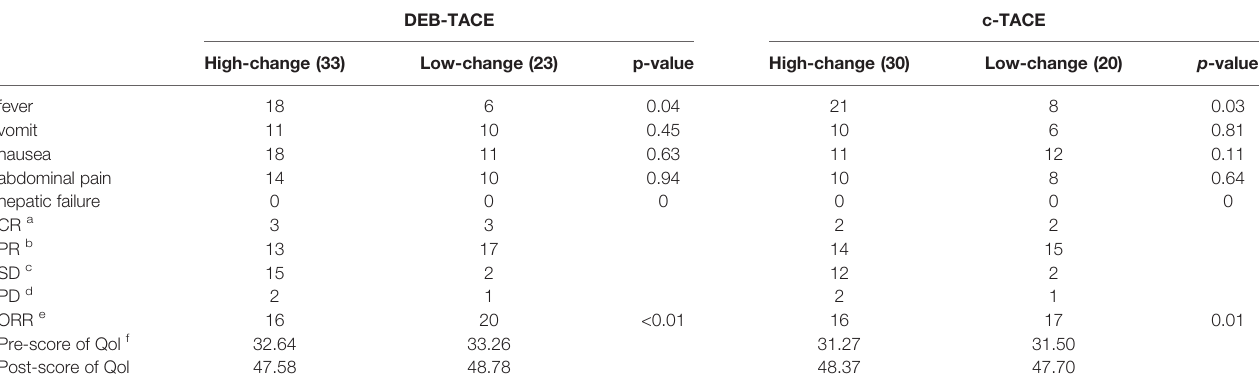
TABLE 6 | Post-expression of HMGB1group, common adverse reactions and treatment